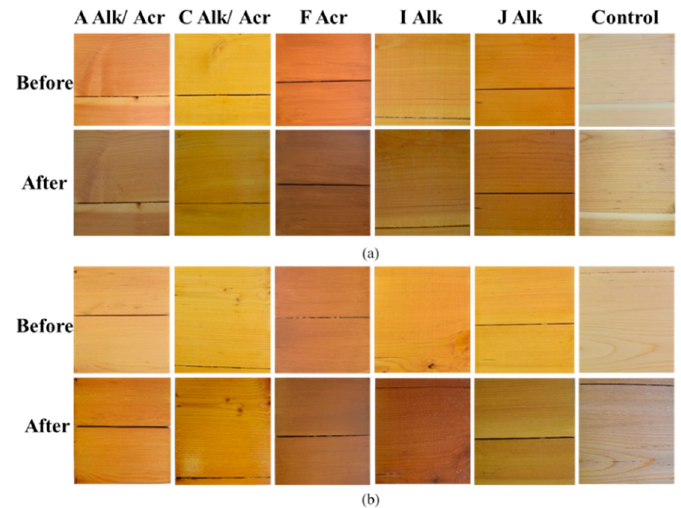
Figure 8. Surface change of selected tested samples. First and second rows correspond to before and after exposure, respectively. ( a ) After 360 h of exposure; and ( b ) after 1800 h of exposure.